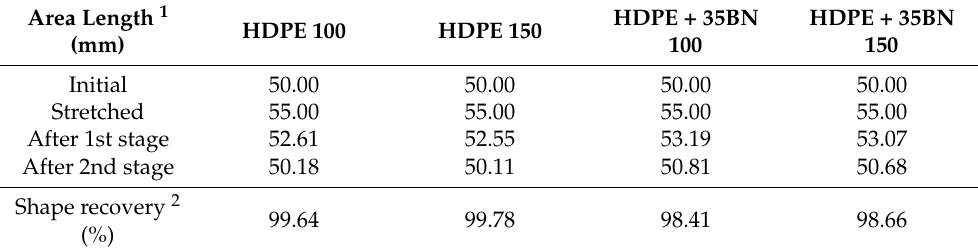
Table 3. Changes of the investigated area length (initial, stretched, and after 1st and 2nd stages) for different types of samples. Percentage of recovery to initial shape length is indicated in the last